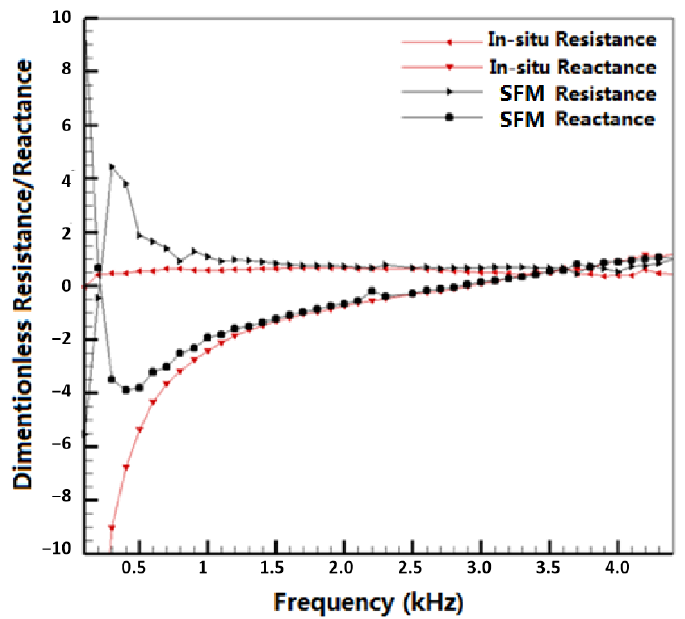
Figure 6. Comparison of measured results between in-situ method and straight forward method.